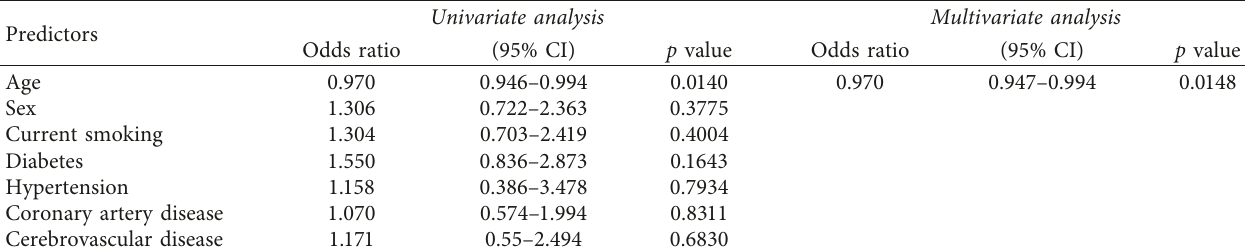
Table 3: Subsequent analysis of additional factors related to clinical event driven target lesion